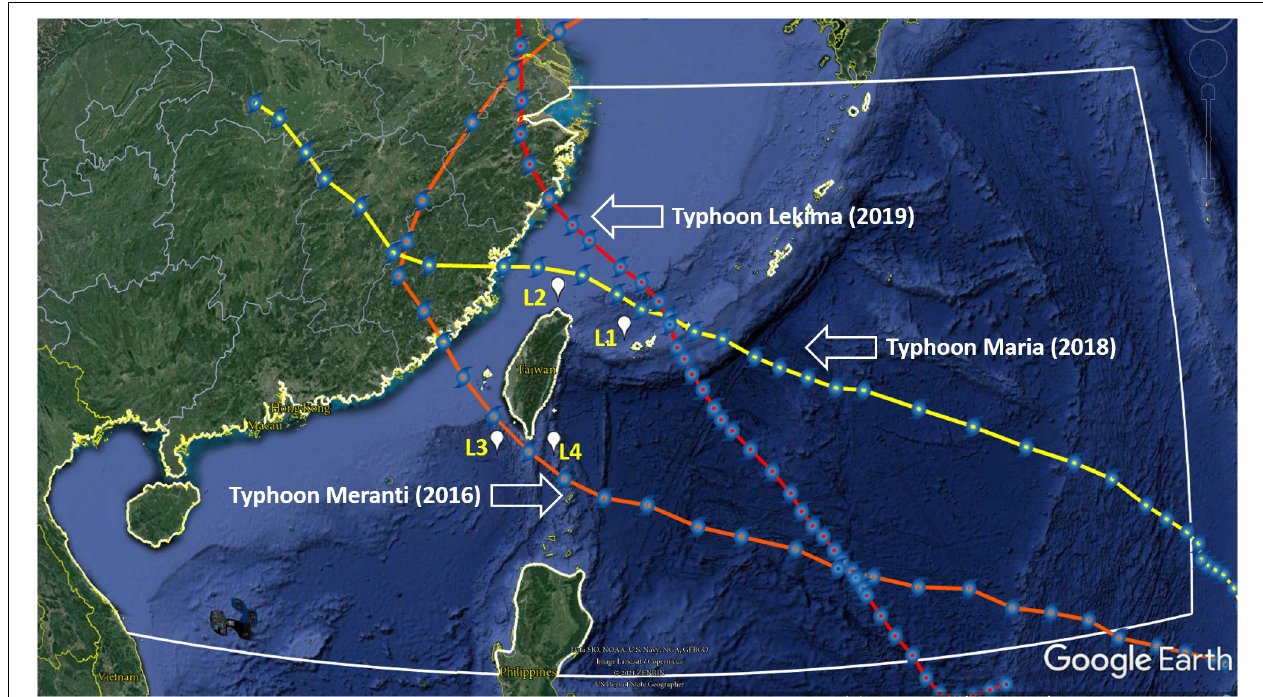
FIGURE 1 | The computational domain of the SCHISM-WWM-III modeling system (sea area within the white line). The red, yellow, and orange lines represent the tracks for Super Typhoons Lekima in 2019, Maria in 2018 and Meranti in 2016, respectively. L1, L2, L3, and L4 are selected representative points for elucidating the effects of binary typhoons on ocean surface waves [typhoon tracks: Regional Specialized Meteorological Center (RSMC) Tokyo-Typhoon Center].